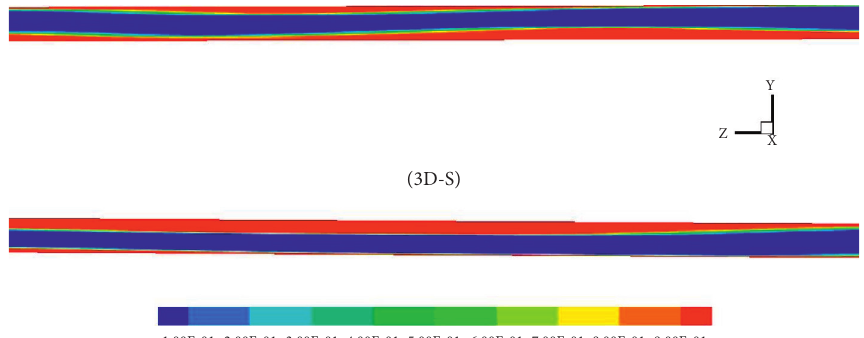
Figure 5: Comparison of the oil volume fraction in the yz -plane for 3D-T and 3D-S configurations.